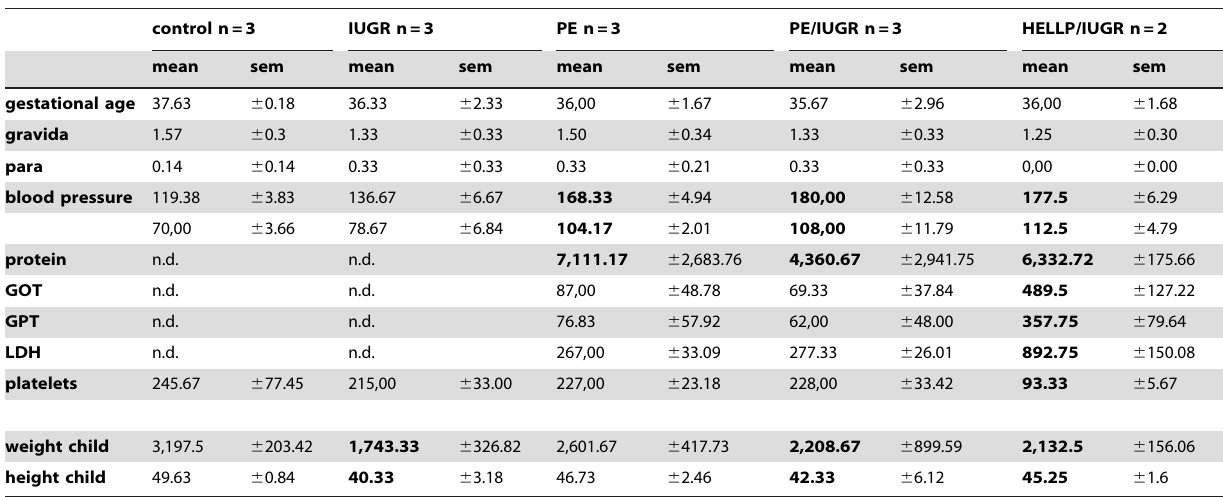
Table 1. Clinical data.